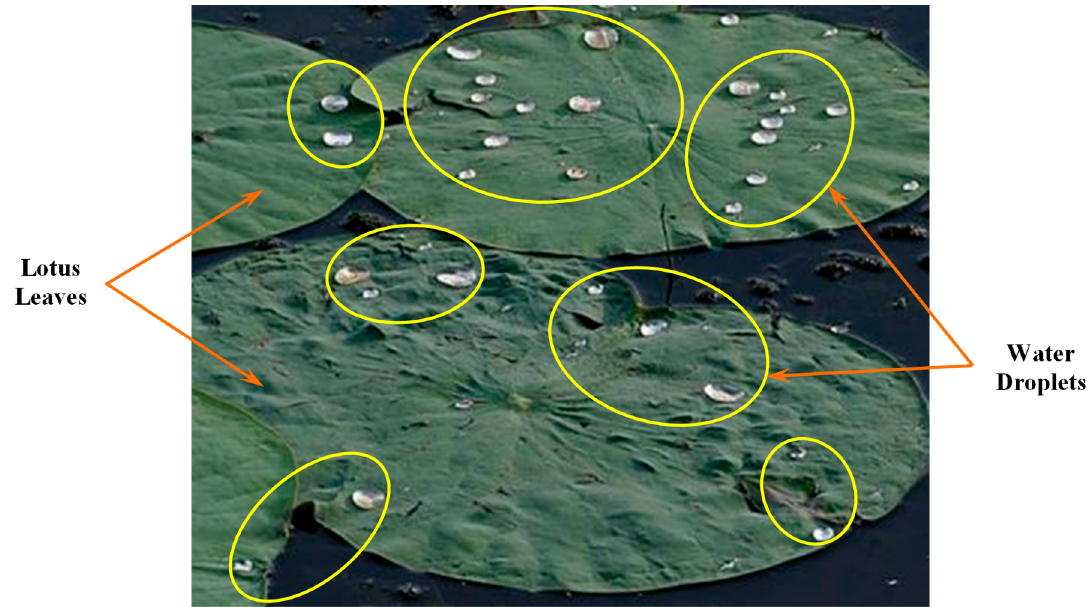
Figure 1. Lotus leaves with “lotus effect” (courtesy of Hossain [22]). The water droplets do not contract and remain buoyant with a spherical structure.